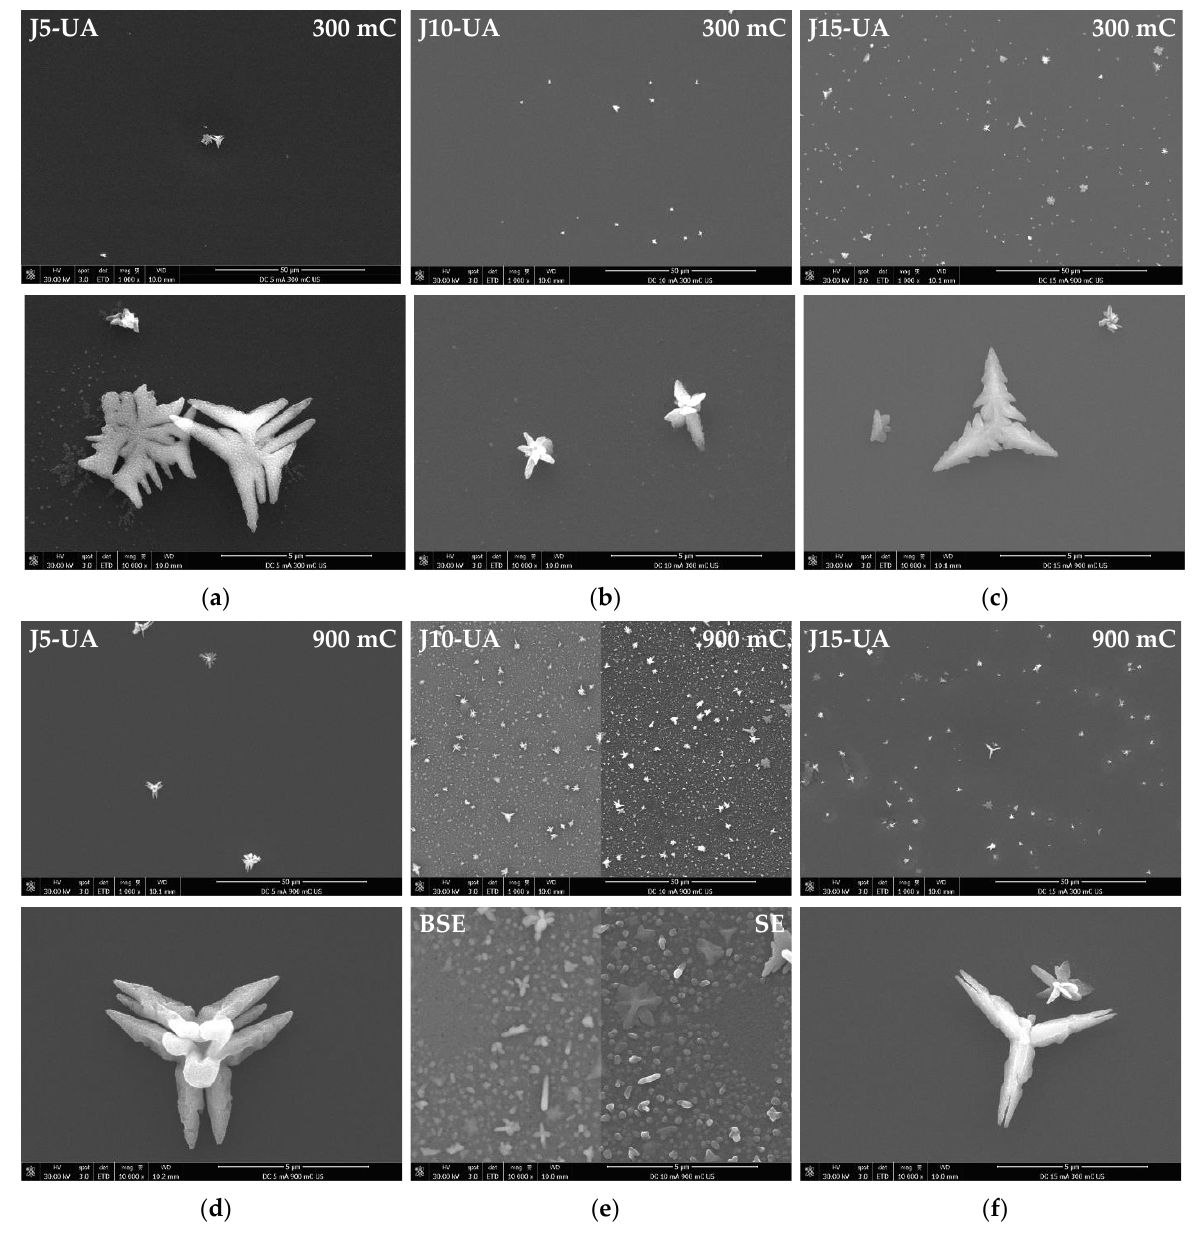
Figure 7. SEM images of the central regions of the as deposited Cu films with current densities of 5 ( a ), 10 ( b ), 15 mA · cm − 2 ( c ) for 300 mC and at the same current densities in ( d ), ( e ), and ( f ), respectively, for 900 mC, under ultrasonic electrolyte